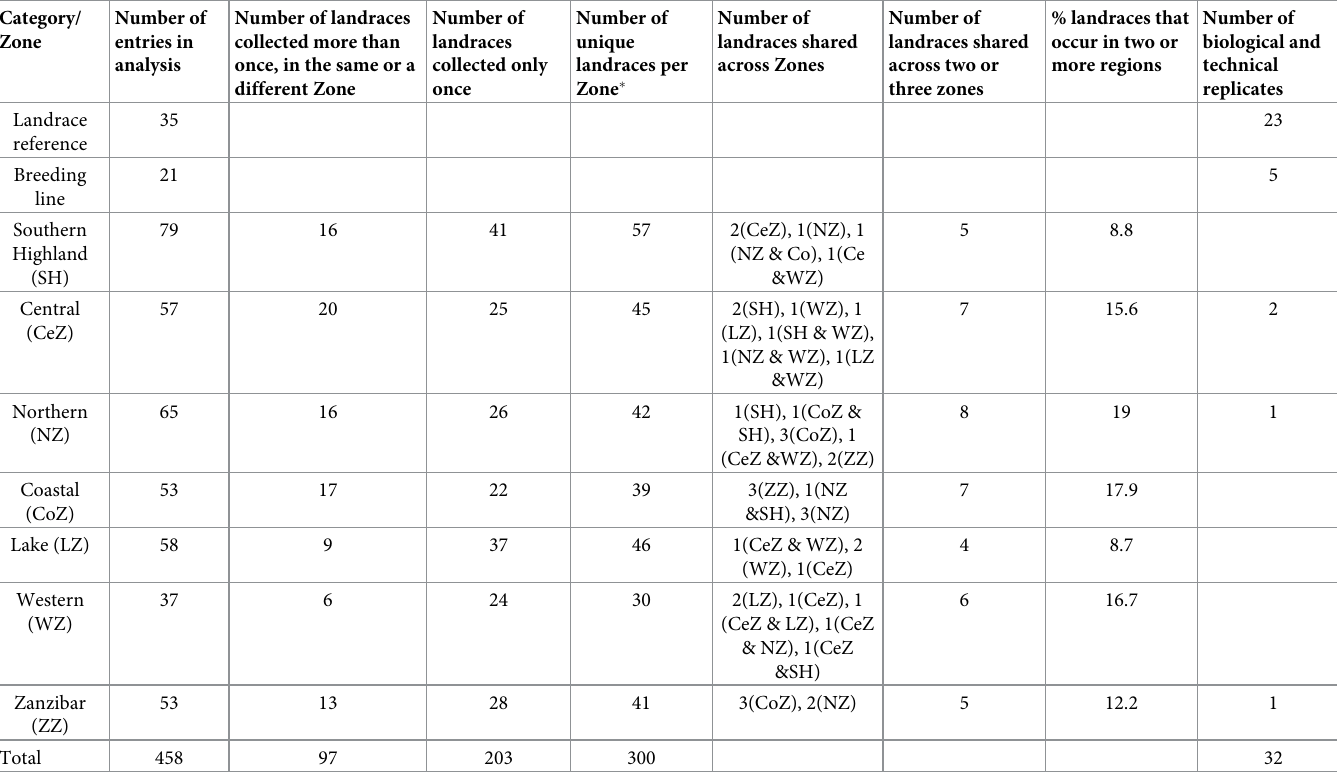
Table 2. Outcome from the identification of unique landraces based on molecular analysis.